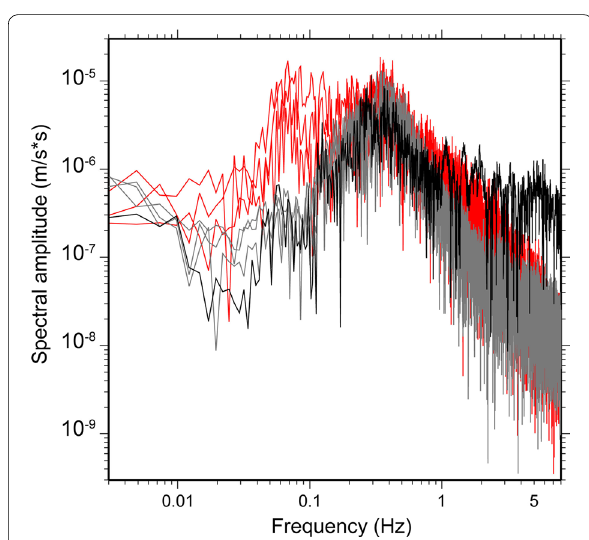
Fig. 4 Spectral amplitudes of various sources. Time window for each calculation was set to 400 s. Red lines show the low-frequency earthquakes (LFEs) and very low frequency earthquakes (VLFEs) that occurred during 12:00–13:00 on June 1, 2005 (UT). Black line shows the ordinary earthquake (magnitude 2.4), which occurred at 10:44 on May 27, 2005 (UT). Gray lines show the ambient